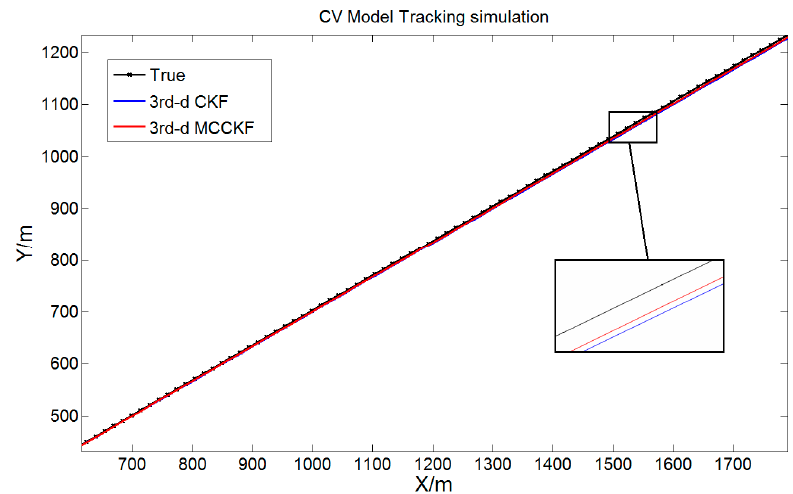
Figure 2. Tracking trajectory of the 3rd-drgree CKF and the 3rd-degree MCCKF under non-Gaussian noise conditions in Equation (61).